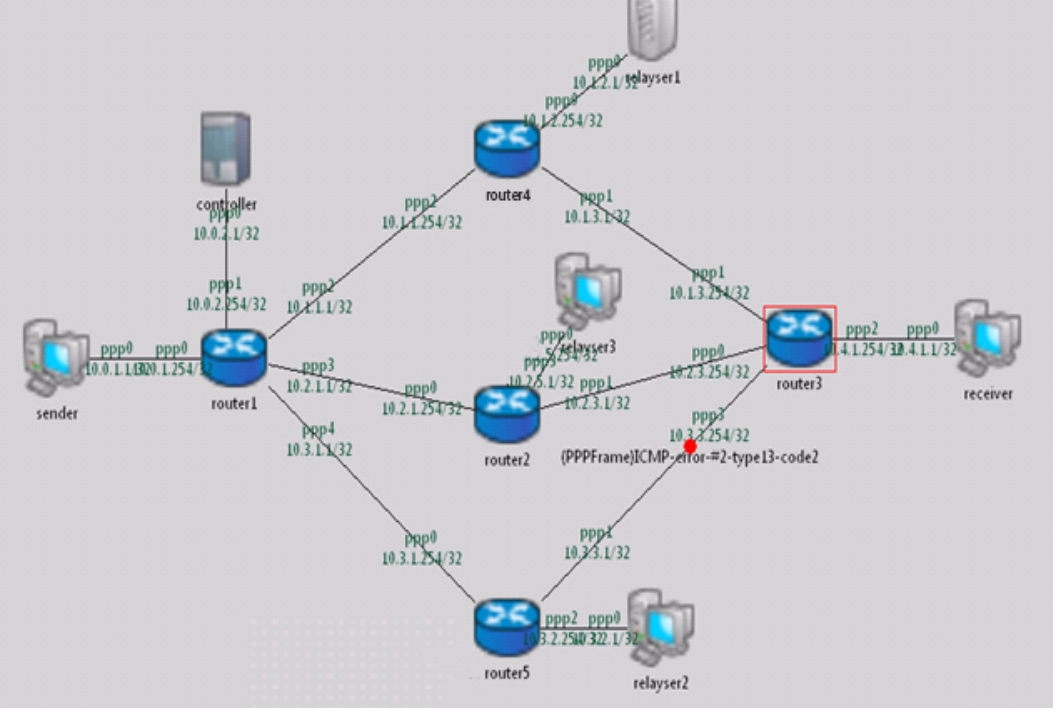
Figure 5. The topology of the test network.